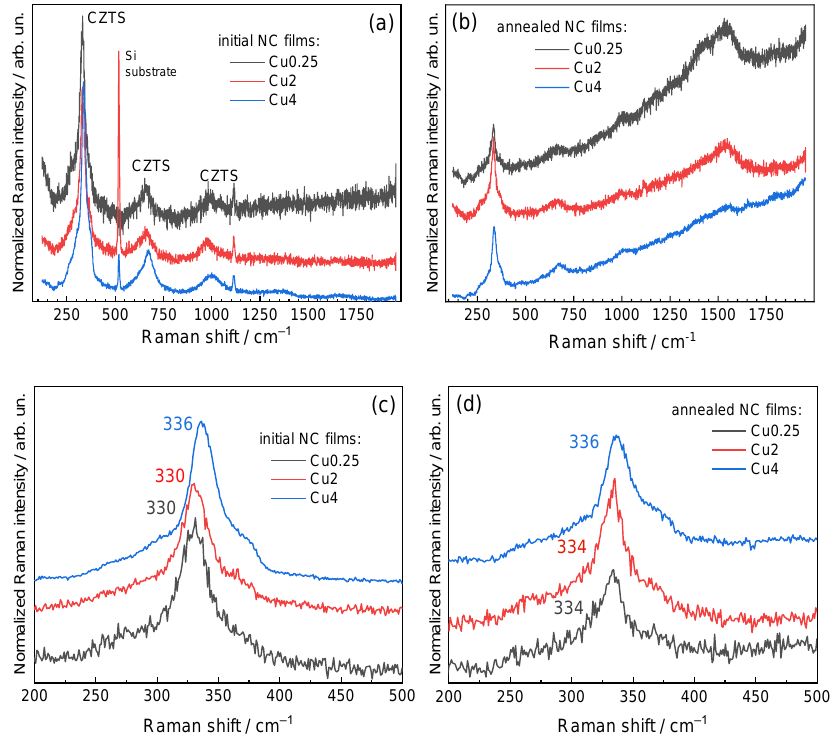
Figure 4. Raman spectra ( λ exc = 514.7 nm, 0.15 mW) of the initial ( a , c ) and annealed ( b , d ) CZTS NC films with different nominal Cu content. The spectra in a broad spectral range are shown in ( a , b ), while ( c , d ) shows in more detail the range of the first-order CZTS phonons. The sharp peak at 1100 cm −1 is an artifact (a room light). In ( b ), the background, increasing toward larger wavenumbers, is due to PL of the carbonized ligand.